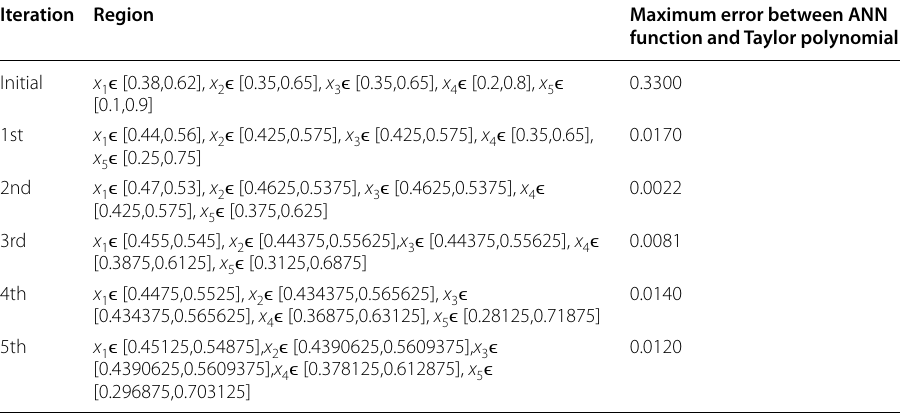
Table 1 Regions for 5 variables function for various iterations Iteration